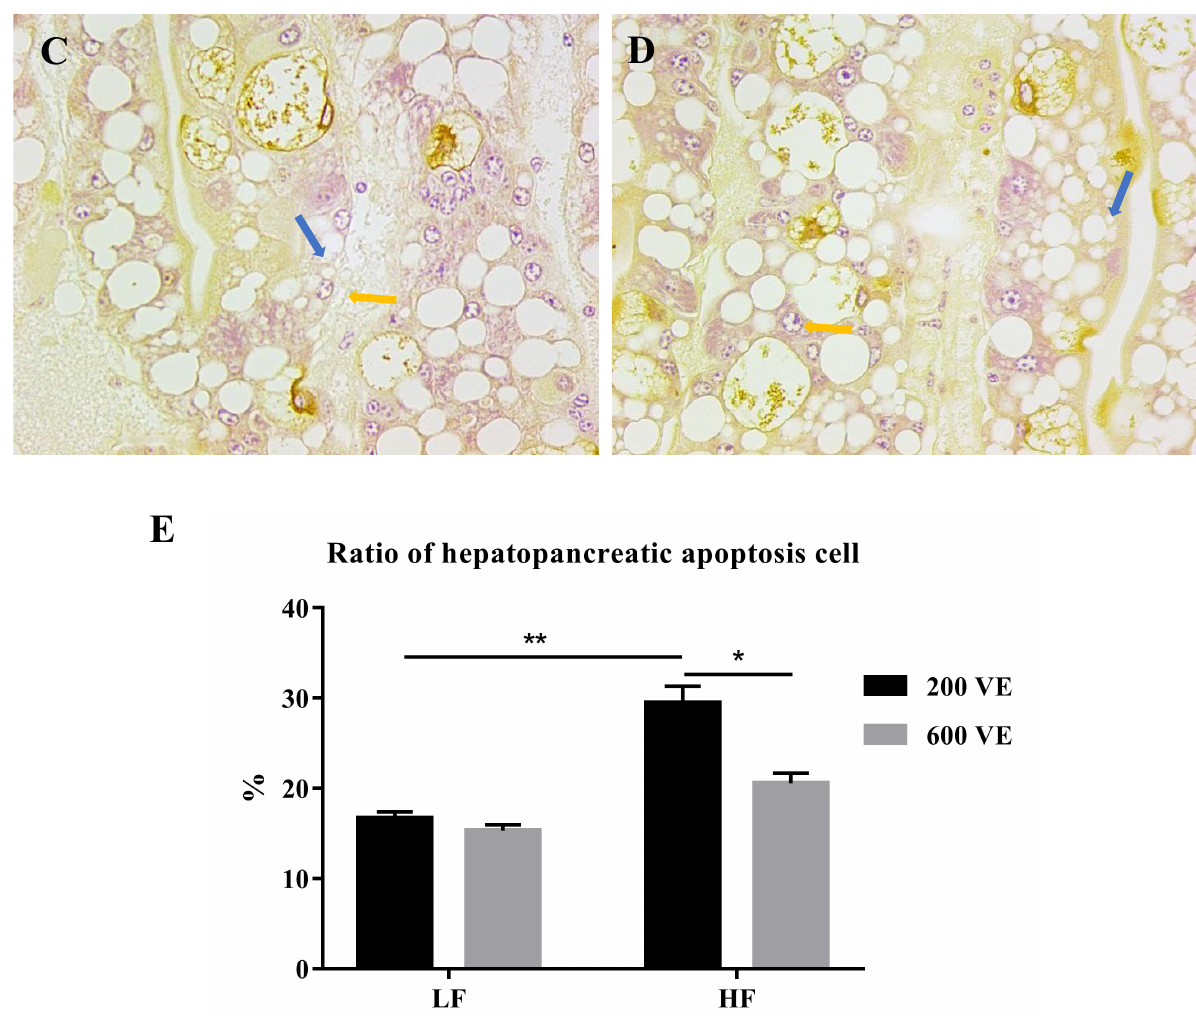
Figure 4. Hepatocyte apoptosis of Macrobrachium rosenbergii fed with different dietary fat and VE levels. ( A ) prawns fed diet including 9% fat and 200 mg/kg VE; ( B ) prawns fed diet including 9% fat and 600 mg/kg VE; ( C ) prawns fed diet including 13% fat and 200 mg/kg VE; ( D ) prawns fed diet including 13% fat and 600 mg/kg VE; ( E ) ratio of hepatopancreatic apoptosis cells ( n = 3). Blue arrow: normal cells; yellow arrow: apoptotic cells. **: p < 0.01, *: p < 0.05.